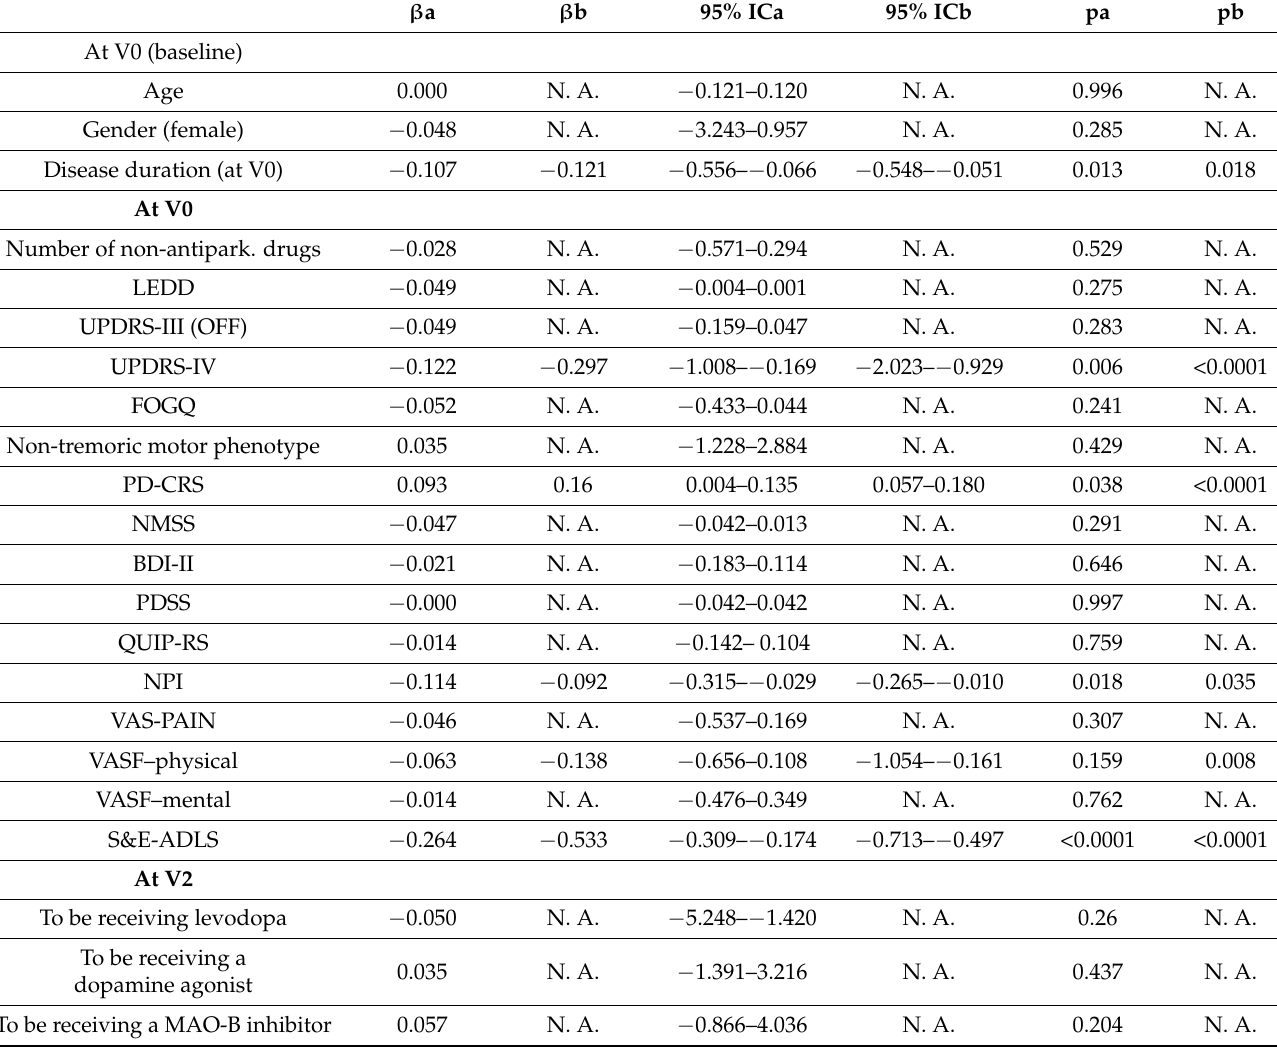
At V0 Number of non-antipark.